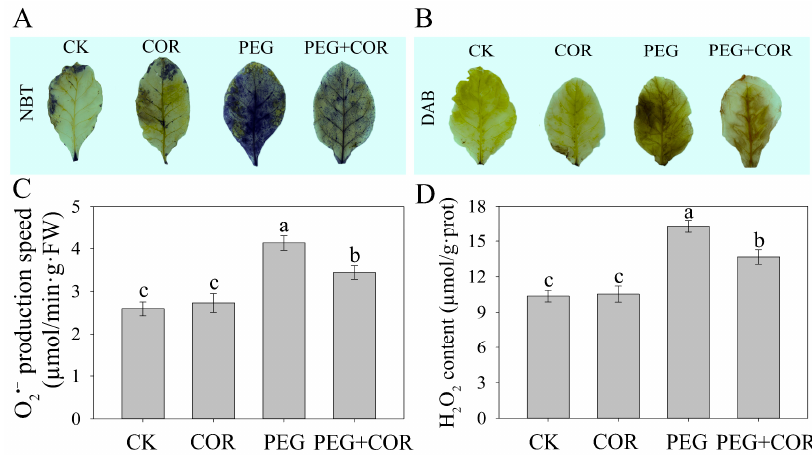
Figure 2. Effect of coronatine on reactive oxygen species (ROS) content in leaves of tobacco seedlings under osmotic conditions. In situ detection of O 2• − by nitrotetrazolium blue chloride (NBT) staining ( A ), in situ detection of H 2 O 2 by 3,3 ′ -diaminobenzidine (DAB) staining ( B ), the generation of O 2• − ( C ) and the content of H 2 O 2 ( D ) in tobacco leaves. Values with bars are the means ± SDs (n = 5), and different letters indicate significant differences at p < 0.05.